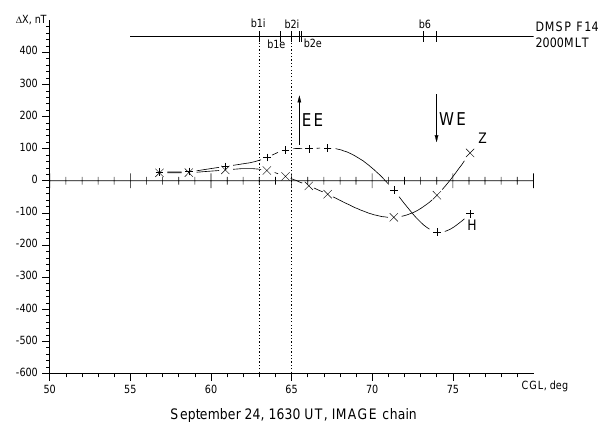
Fig. 5. Latitudinal cross sections of the magnetic disturbance H and Z components for the IMAGE chain at 16:30 UT on 24 September 1998 (bottom panel). The boundaries of particle precipitation re- gions within the close UT interval (top panel). Measurements from the DMSP F14 pass over auroral latitudes at 20:00 MLT were used. Dashed vertical lines depict the equatorward boundary b1i of auro- ral particle precipitation region and b2i magnetically mapped to the inner boundary of the magnetospheric tail current